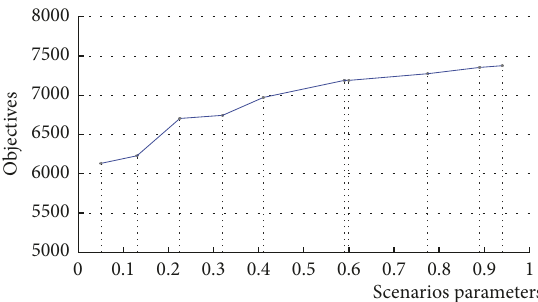
Figure 7: The change of the objectives under different scenarios